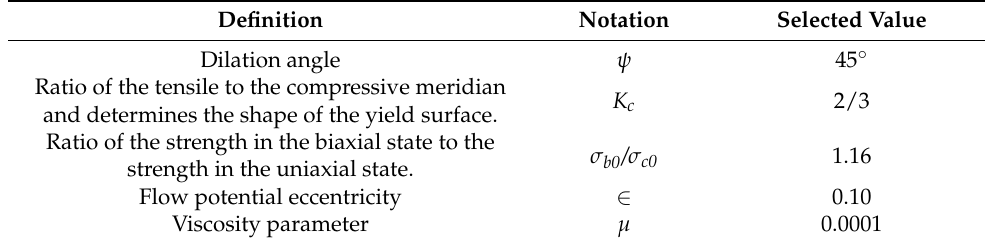
Table 1. Parameters input of the CDP model.